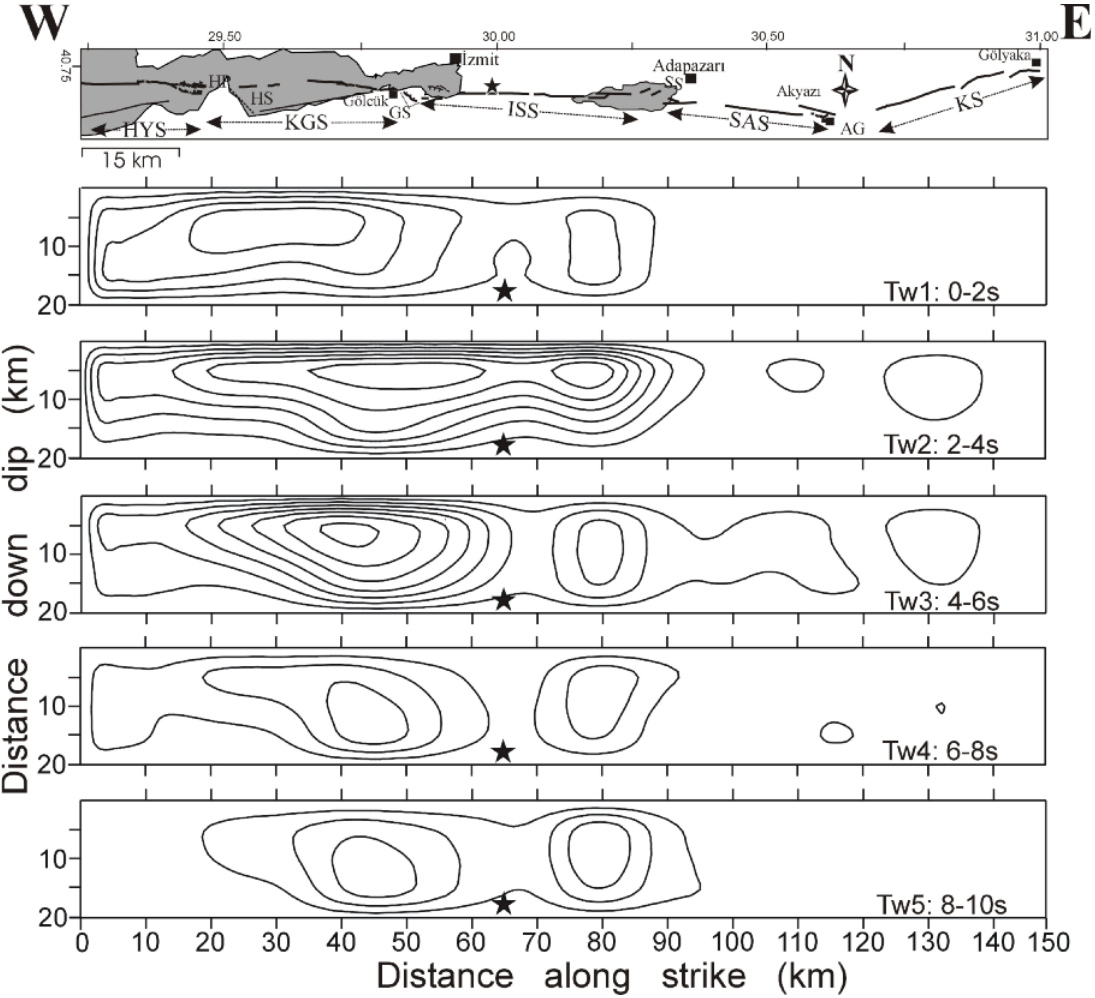
! Figure 8. Individual slip contributions of each time window to the final coseismic slip model shown in Figure 6a. Each time window represents the slipped fault areas in the time interval indicated at the right of the windows, following the passage of the fastest rupture front. Slip larger than 30 cm is contoured at 30-cm intervals. See caption of Figure 3 for abbreviations used in the